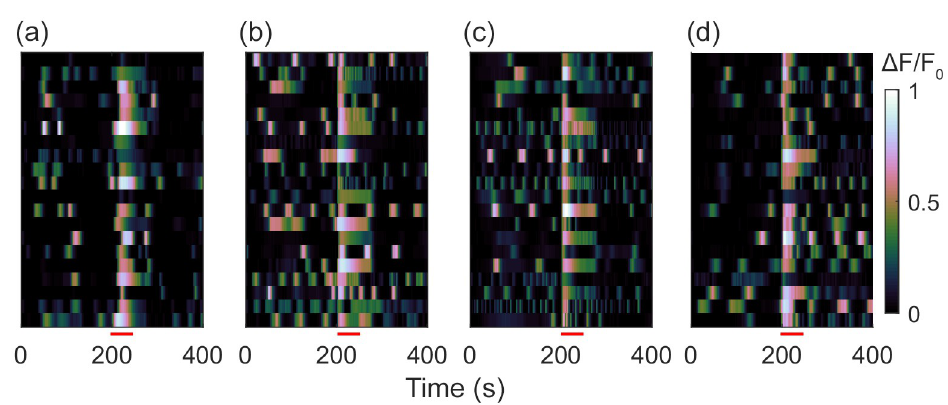
Fig 7. Calcium signalling in patterned hNT astrocytes. Temporal raster plots of Ca 2+ signalling in the astrocytes patterned on (a) parylene-HT, (b) parylene-D, (c) parylene-N, (d) parylene-C/SiO 2 substrates. Astrocytes were stimulated with 10 μ m ATP at 200 s, as indicated by the red